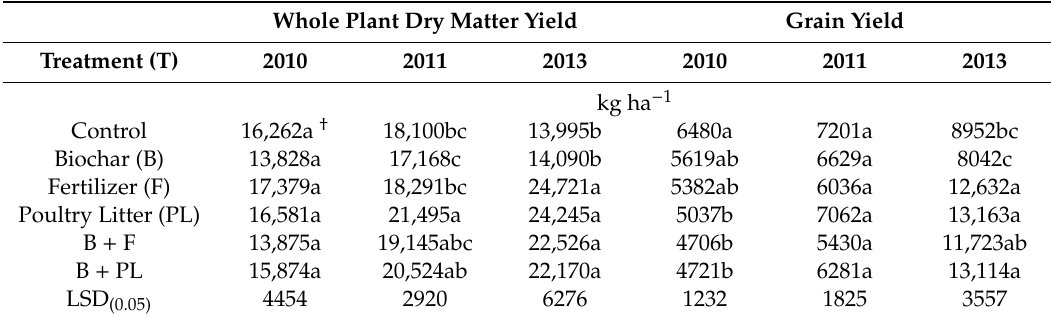
Table 2. Whole plant dry matter and grain yield influenced by di ff erent treatment and growing season year.